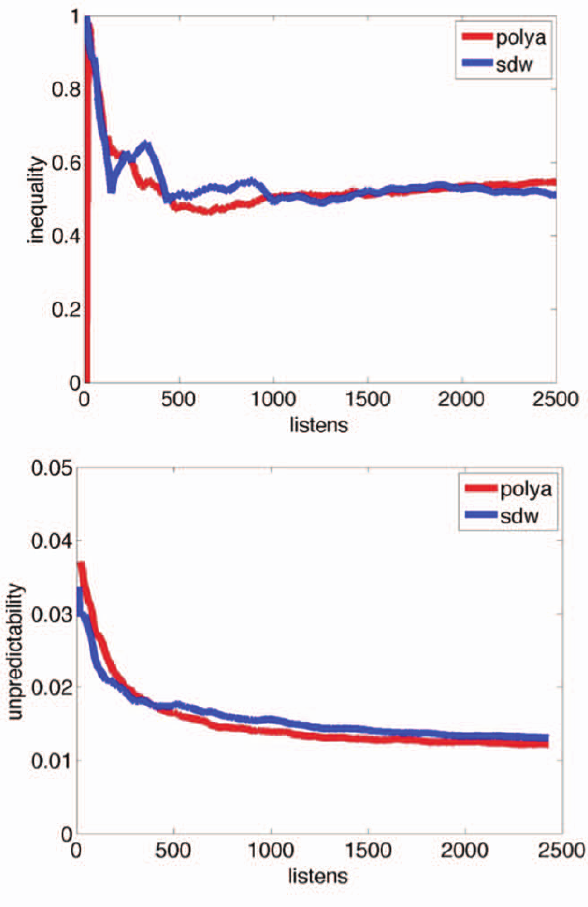
Figure 4. Inequality (top) and unpredictability (bottom) over the course of the market, with alpha=900. Inequality is shown for Experiment 1, world 3. RMSE of simulated market’s unpredictability is=0.0017, and average of inequality is=0.093.